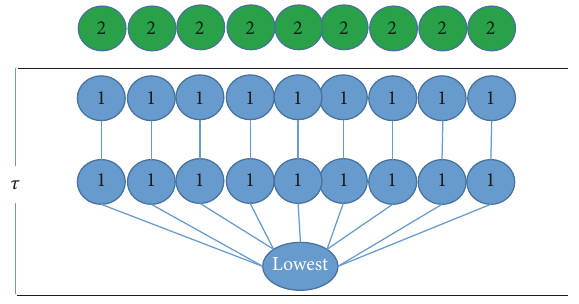
Figure 2: The selection of the root